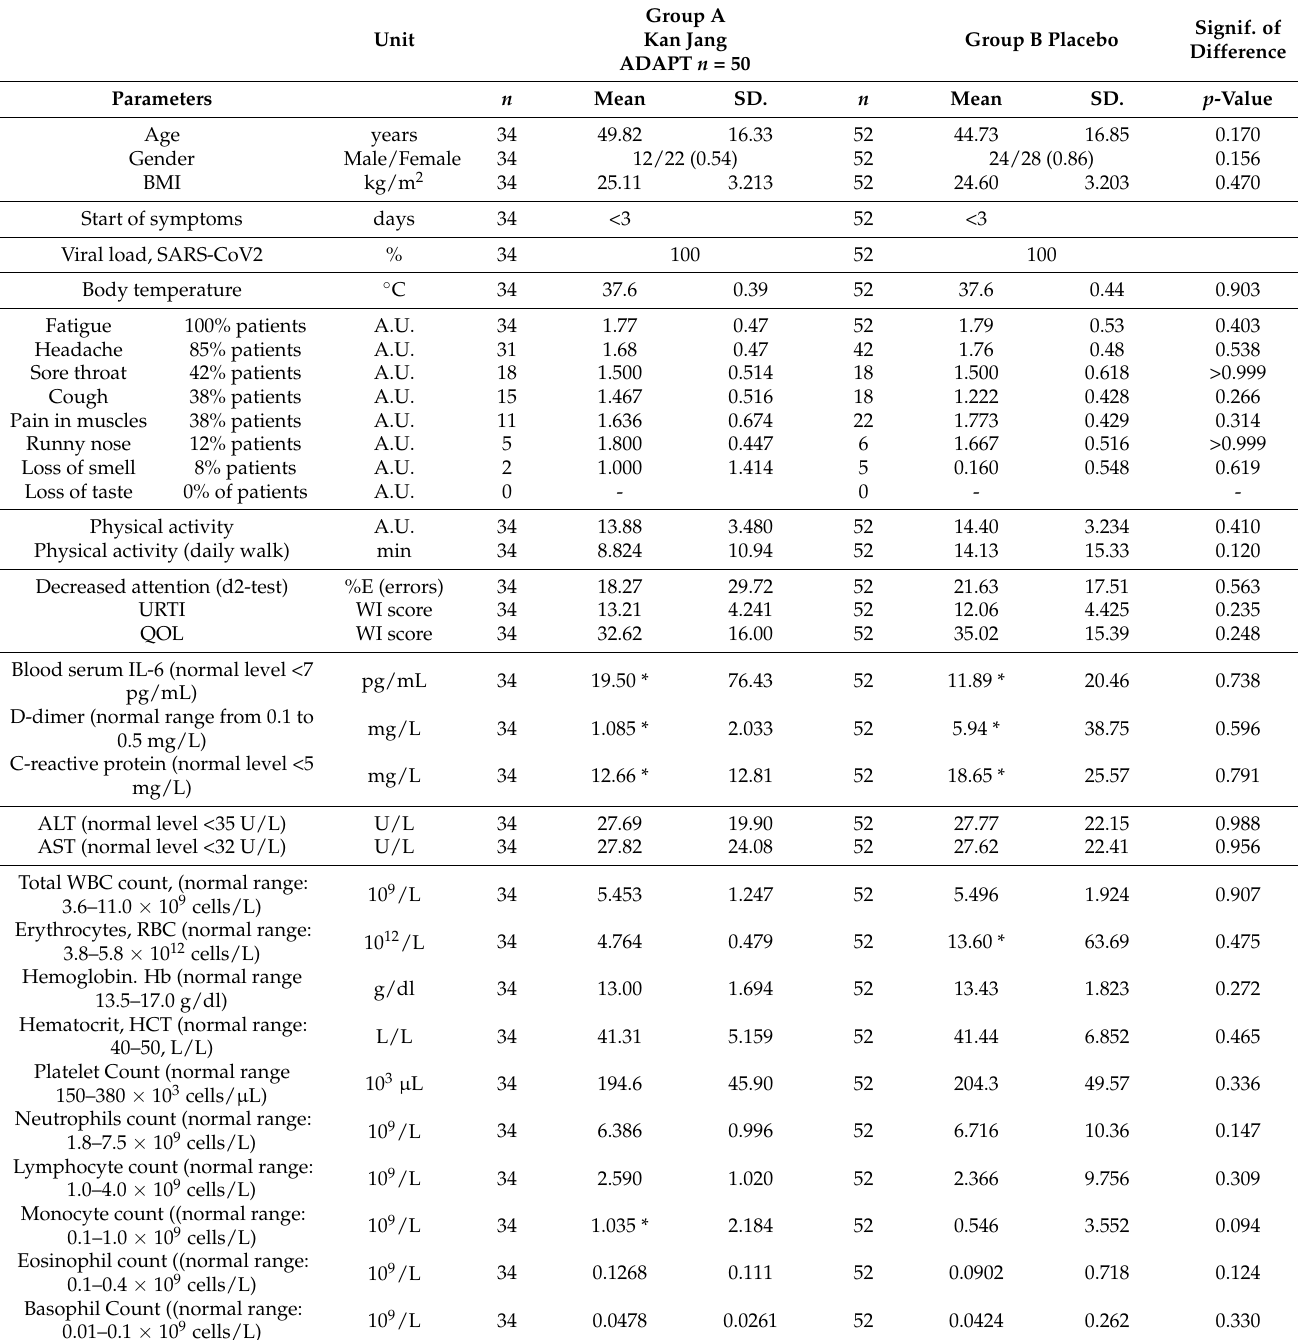
Table 1. Baseline demographic characteristics, outcome measures, and laboratory biochemical and hematological measurements. Unit